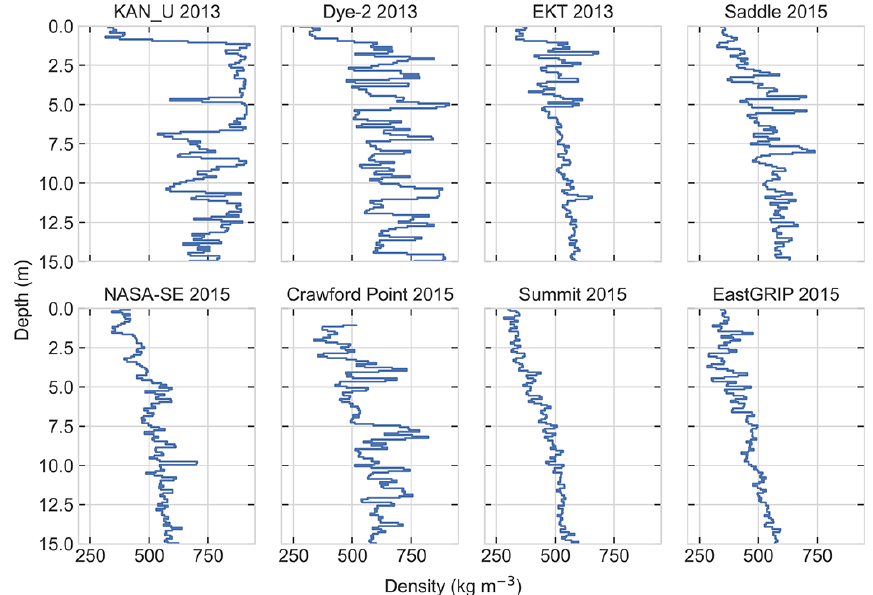
Figure 3. Firn density profiles at the first visit of each site. These and other density profiles from FirnCover are available from Koenig and Montgomery